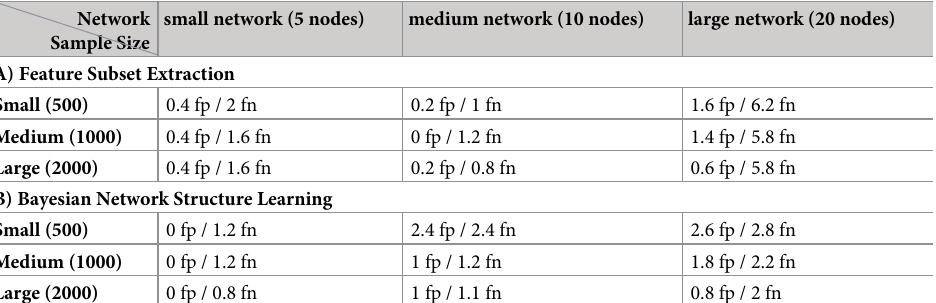
Table 1. The table reports the results of the simulation study. A) Feature Subset Extraction: Average of (false posi- tive (fp) / false negative (fn)) features (averaged over 10 iterations). B) Relearned Network Structure: Average of false positive (fp) / false negative (fn) arcs of the relearned network structure (averaged over 10